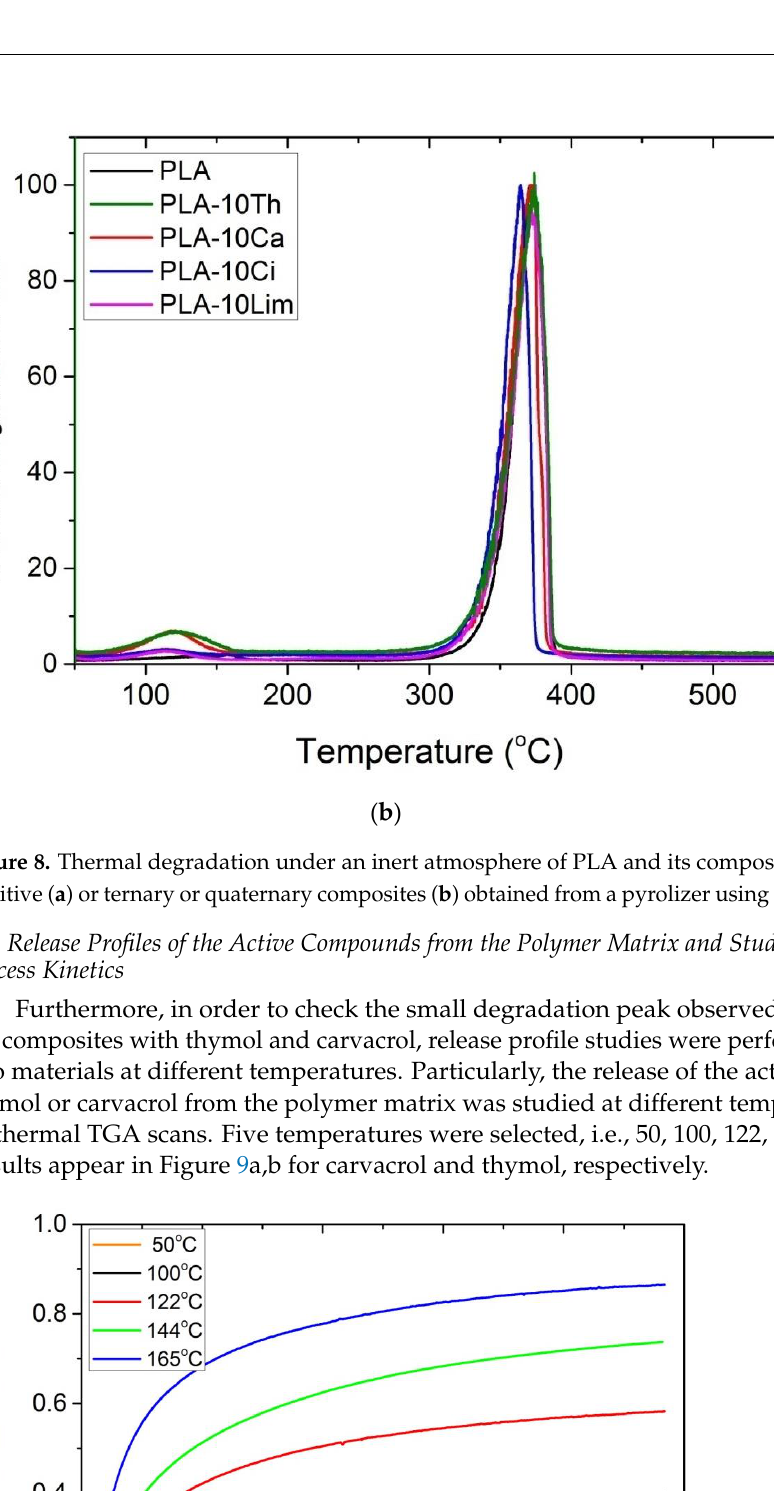
( b ) Figure 9. Release profiles of carvacrol ( a ) or thymol ( b ) from the polymer matrix at five different temperatures, 50, 100, 122, 144 and 165 °C. Measurements were carried out isothermally using TGA.